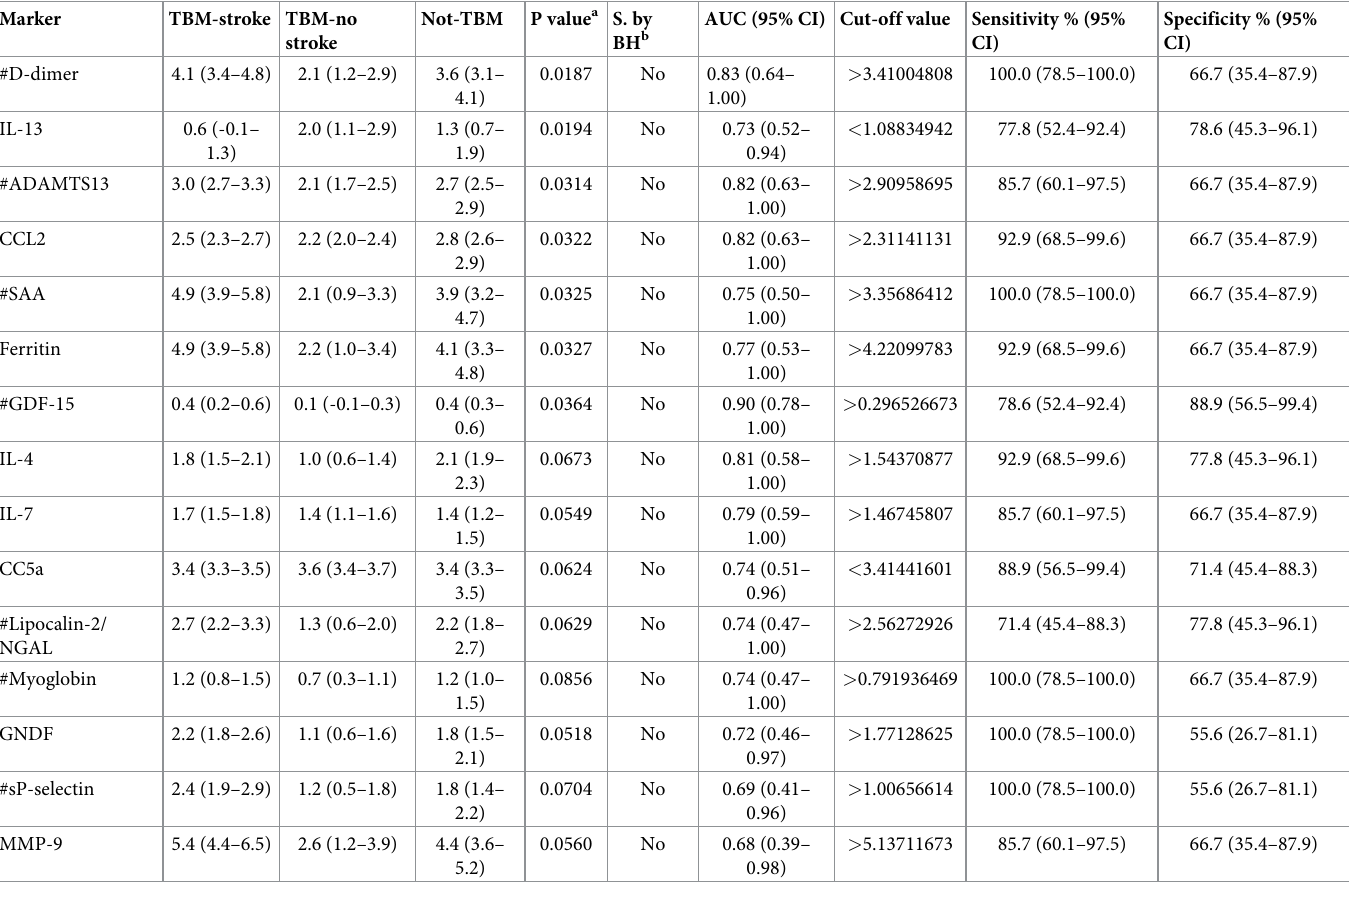
Table 3. Expression of serum host protein markers amongst study participants with TBM and stroke/no stroke at admission, and their accuracies in indicating stroke in TBM patients. The mean values shown (95% confidence intervals in brackets) are the least square (LS) means. Markers showing significant difference (p- value < 0.05) or showing trends (0.05 < p-value � 0.09) between the TBM patients with stroke and no stroke are shown. The expressions of all other host markers are shown in S3 Table. #reported in ng/ml, all other markers are reported in